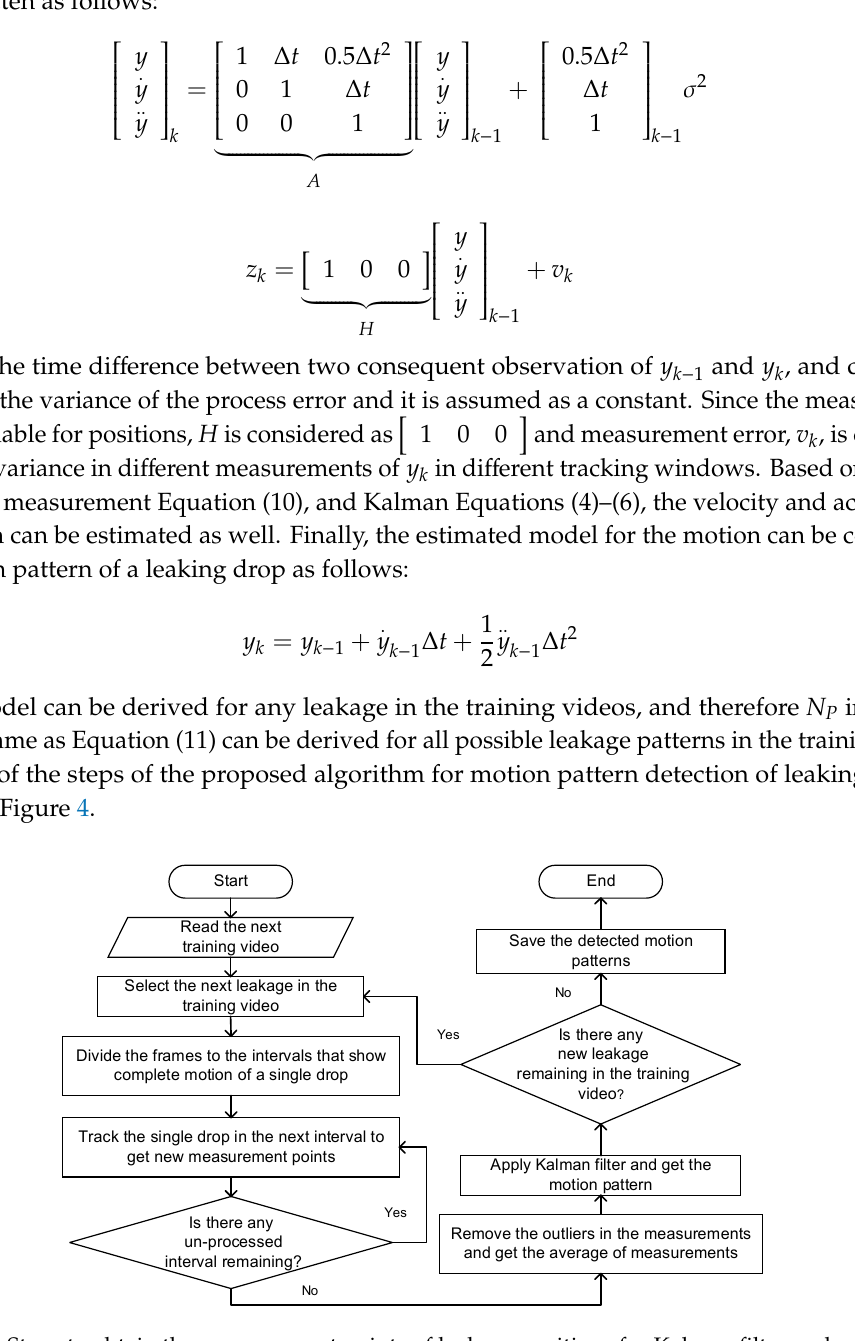
Figure 4. Steps to obtain the measurement points of leakage positions for Kalman filter and motion pattern detection in training videos.